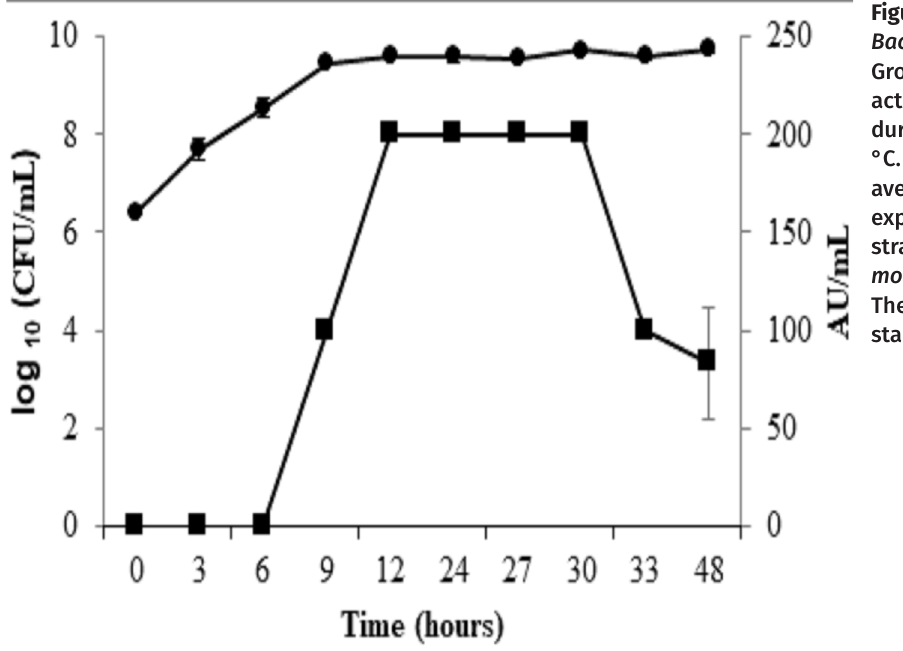
Figure 3. Growth curve of the Bacillus sp . sed 1.4